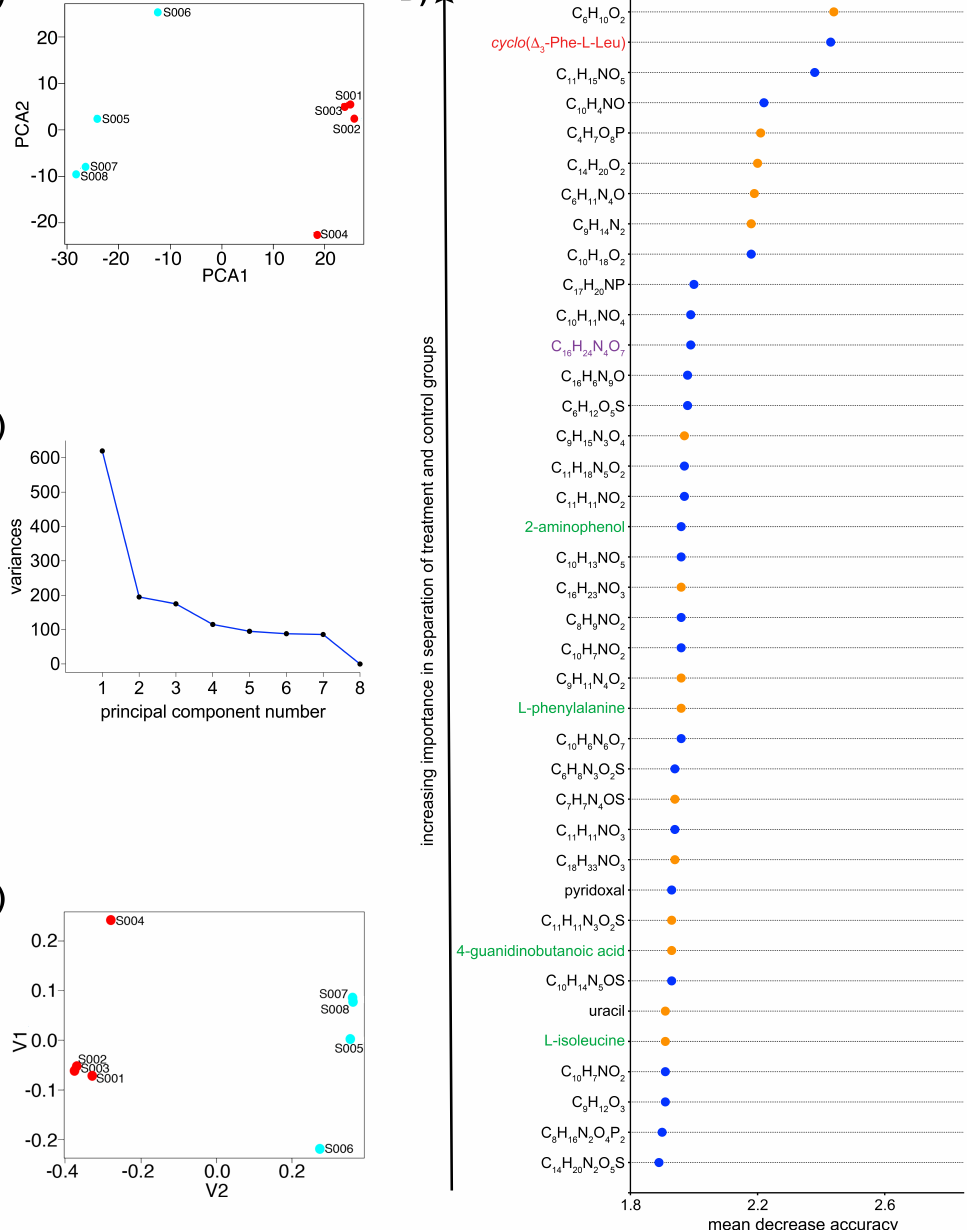
Figure 2. Multivariate analyses of bipyridyl treatment and no-bipyridyl control N. dassonvillei metabolomes. ( A ) A two-dimensional principal component analysis (PCA) score plot supported impacts of bipyridyl on the N. dassonvillei metabolome. Data points corresponding to controls are in red (S001–S004) and are di ff erentiated from light blue data points corresponding to treatments (S005–S008). ( B ) A scree plot of PCA component variances supported that PC1–PC2 account for most of the deviation between treatment and control groups. ( C ) A multidimensional scaling plot of proximity matrix from random forest (RF) segregated treatment and control samples. X- and y-axes indicate multidimensional scaling coordinates, and data points are colored as in ( A ). ( D ) RF variable importance plot of 40 metabolites contributing most toward RF separation of groups. Annotated metabolites associated with amino acid metabolism, based on the KEGG database, are named in green. Previously reported secondary metabolites are named in red, and novel putative molecular formulae with > 10 C are in purple. Blue data points indicate metabolites that decreased in response to bipyridyl, and orange indicates metabolites whose abundance increased in response to this iron